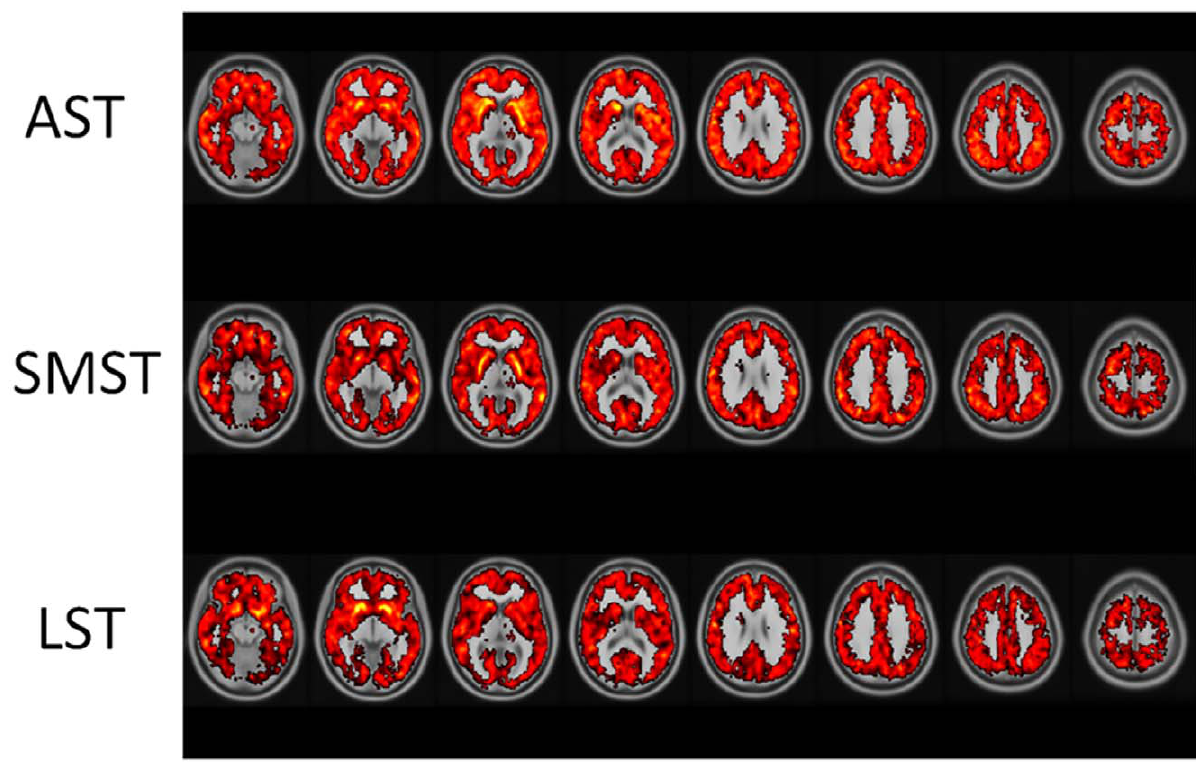
Figure 2. Correlation map of striatal functional subdivisions and extrastriatal regions, in addition to that of within striatal subdivisions. Correlations in brighter color (yellow) represent higher ones in terms of magnitude than those in red.